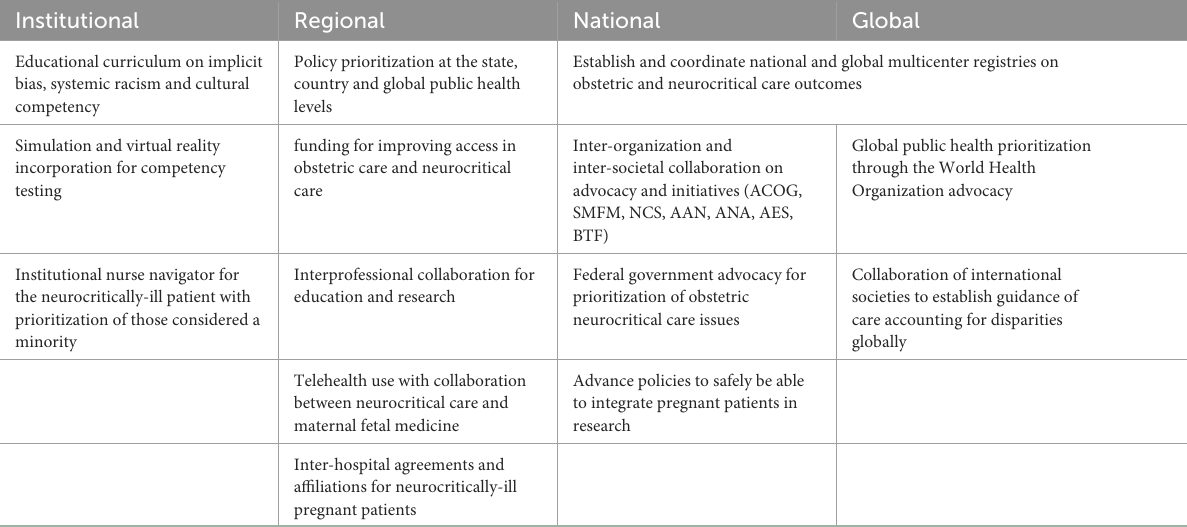
TABLE 2 Potential targeted and actionable interventions to address disparities in obstetric care and neurocritical care of pregnant patients who are neurotically ill.